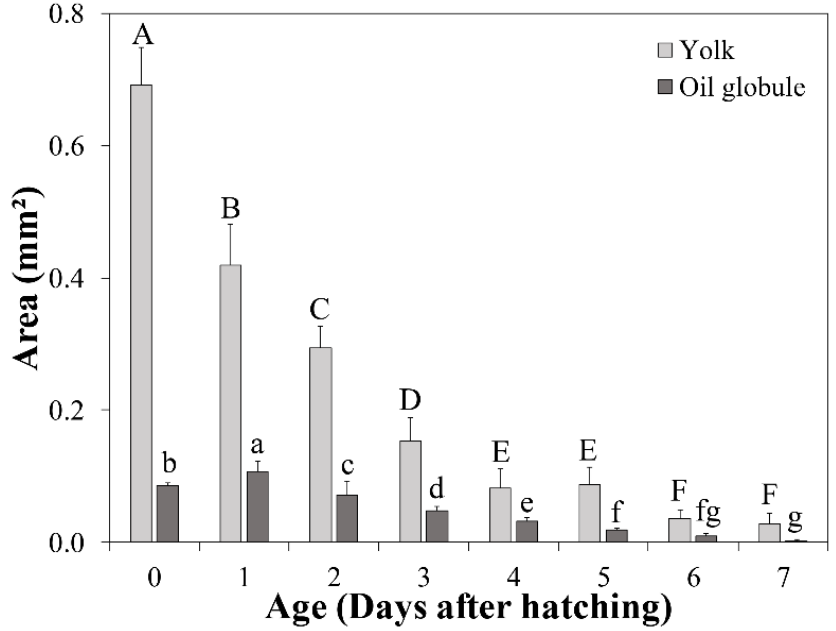
Figure 6. Yolk sac and oil globule utilization in Anguilla japonica larvae. Values are means ± SD. Different uppercase letters denote significant differences between yolks (light gray). The significant differences between oil globules (dark gray) are shown using different lowercase letters ( p < 0.05).